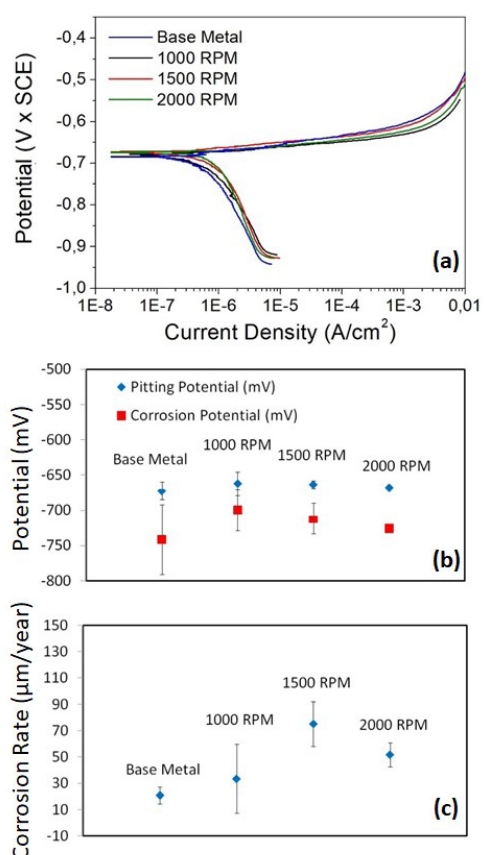
Figure 8. (a) Potentiodynamic polarization curves; (b) Corrosion and pitting potentials and (c) Corrosion rate obtained by Tafel extrapolation method for BM and welded joints at different rotational